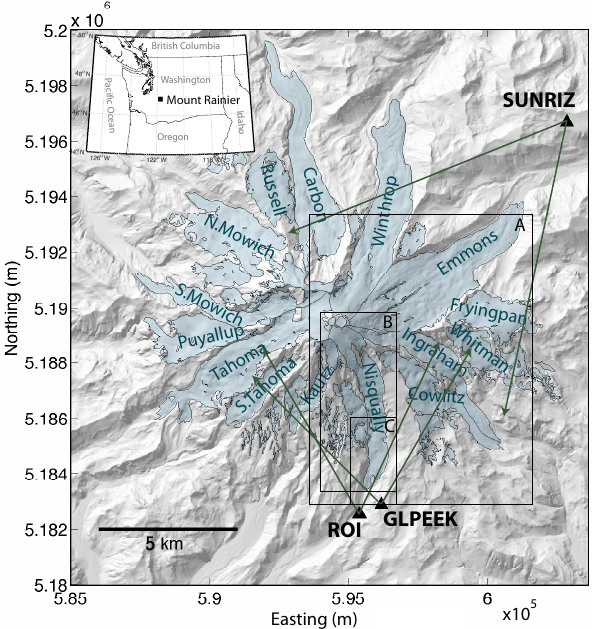
Figure 1. Glaciers at Mount Rainier and locations of viewpoints used for ground-based radar interferometry. Instrument view angle ranges are indicated by arrows extending away from each viewpoint location. Boxes A–C show zoom areas for later figures. Inset map shows regional location of Mount Rainier. Glacier outlines in this and subsequent figures are from Robinson et al.